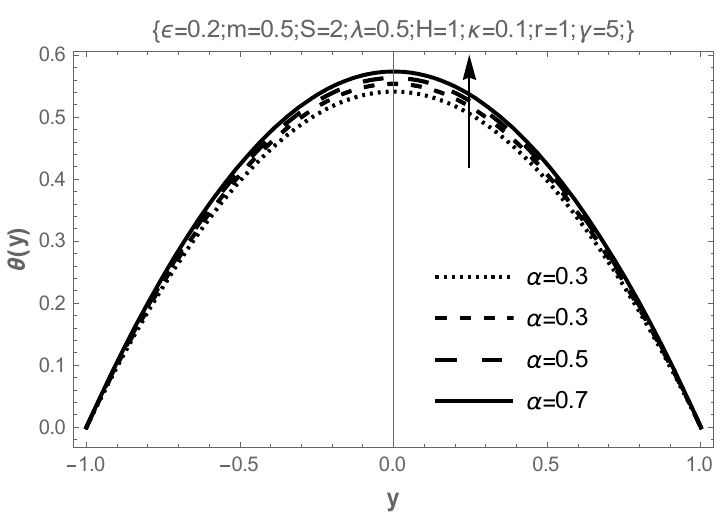
Figure 7. Effect of the porous permeability variation parameter on fluid temperature.